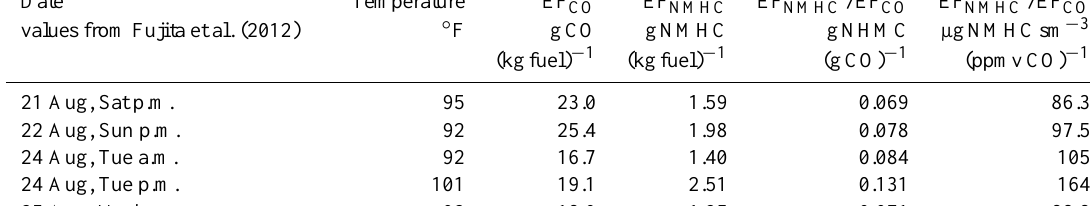
Table 2. Measured fleet-averaged fuel-based CO and NMHC emission factors (gkg − 1 of fuel) reported by Fujita et al. (2012); Gentner et al. (2012). Numerical values in the right-most column are calculated using the conversion factor 1250µgCOsm − 3 (ppmvCO) − 1 . Date Temperature EF CO EF NMHC EF NMHC /EF CO EF NMHC /EF CO values from Fujita et al. (2012) ◦ F gCO gNMHC gNHMC µgNMHCsm − 3 (kgfuel) − 1 (kgfuel) − 1 (gCO) − 1 (ppmvCO) − 1 21 Aug, Sat p.m. 95 23.0 1.59 0.069 86.3 22 Aug, Sun p.m. 92 25.4 97.5 24 Aug, Tue a.m. 92 105 24 Aug, Tue p.m. 101 0.131 164 25 Aug, Wed a.m. 92 18.9 0.071 88.8 25 Aug, Wed p.m. 102 30.4 0.100 125 28 Aug, Sat a.m. 72 29 Aug, Sun a.m. Mean Median Values from Gentner et al.